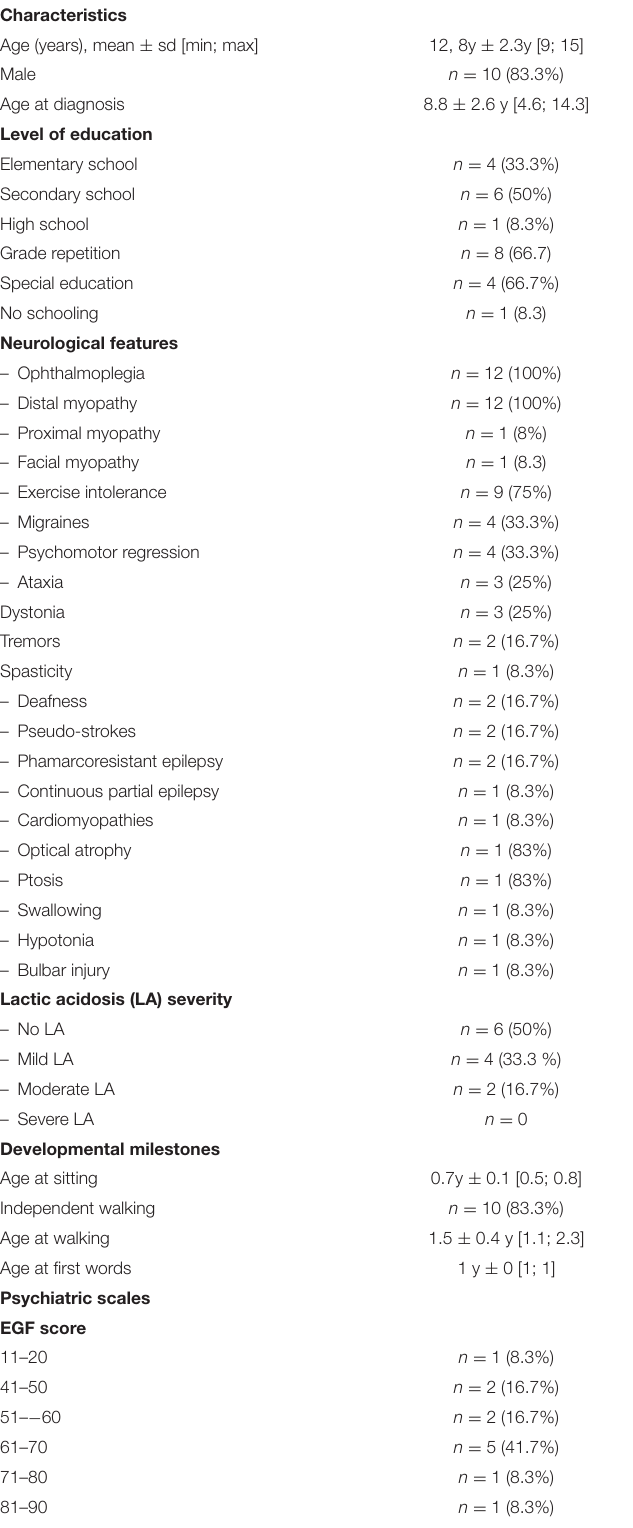
TABLE 2 | Somatic and psychiatric characteristics of the studied population of children with mitochondrial disorder ( n = 12).